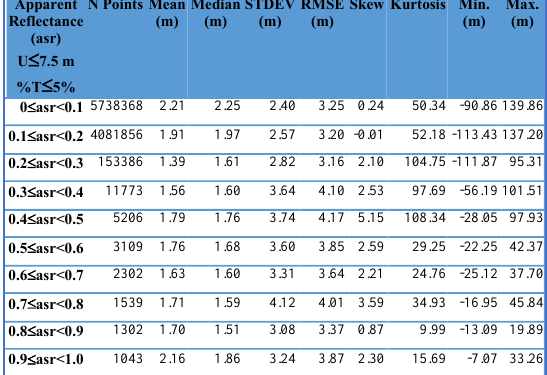
Table 5. Statistics for elevation differences SRTM90 –